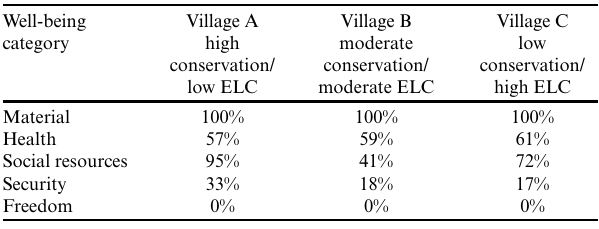
Table 5. Frequency of components named in individual interviews in each village, aggregated by well-being category. ELC = economic land commission.